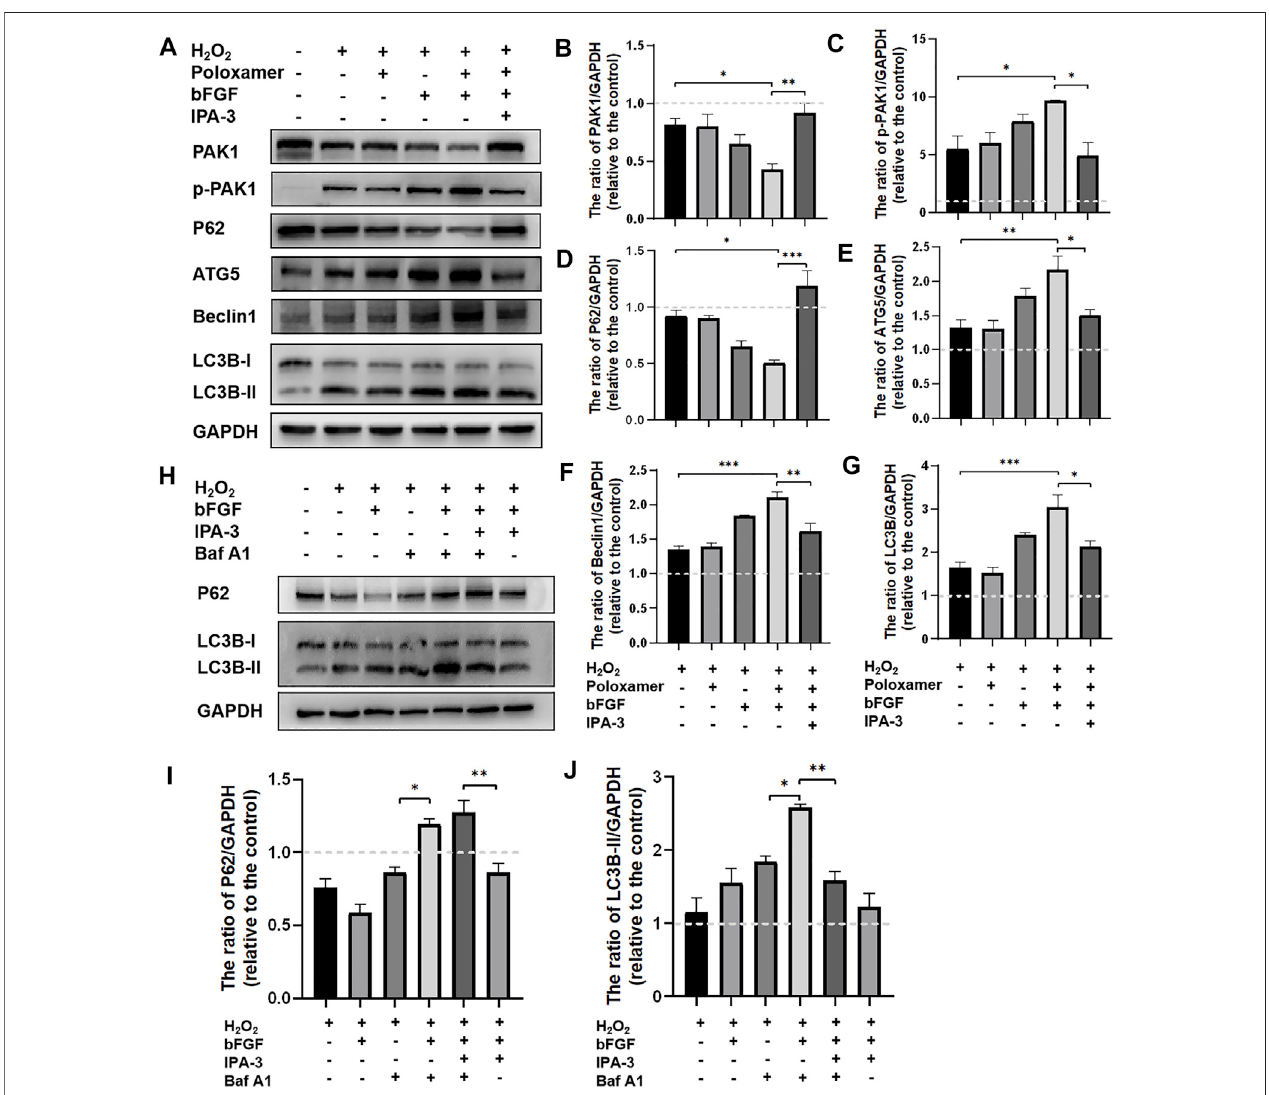
FIGURE 5 | P-bFGF activated the PAK1 pathway to promote autophagy of SCs. (A) Representative western blot images of PAK1, p-PAK1, P62, ATG5, Beclin1 and LC3B expression. (B) Quanti fi cation of the levels of PAK1 protein; H 2 O 2 group vs. P-bFGF group: * p < 0.05, P-bFGF group vs. IPA-3 group: ** p < 0.01. (C) Quanti fi cation ofthelevels ofp-PAK1 protein; H 2 O 2 group vs. P-bFGFgroup: * p < 0.05, P-bFGFgroup vs. IPA-3group: * p < 0.05. (D) Quanti fi cation ofthe levelsofP62 protein; H 2 O 2 group vs. P-bFGF group: * p < 0.05, P-bFGF group vs. IPA-3 group: *** p < 0.001. (E) Quanti fi cation of the levels of ATG5 protein; H 2 O 2 group vs. P-bFGF group: ** p < 0.01, P-bFGF group vs. IPA-3 group: * p < 0.05. (F) Quanti fi cation of the levels of the Beclin1 protein; H 2 O 2 group vs. P-bFGF group: *** p < 0.001, P-bFGF group vs. IPA-3 group: ** p < 0.01. (G) Quanti fi cation of the levels of the LC3B-II protein; H 2 O 2 group vs. P-bFGF group: *** p < 0.001, P-bFGF group vs. IPA-3 group: * p < 0.05. (H) Representative western blot images of P62 and LC3B expression. (I) Quanti fi cation of the levels of the P62 protein; H 2 O 2 +Baf group vs. H 2 O 2 +bFGF + Baf group: * p < 0.05, H 2 O 2 +bFGF + Baf + IPA-3 group vs. H 2 O 2 +bFGF + IPA-3 group: ** p < 0.01. (J) Quanti fi cation of the levels of the LC3B-II protein;